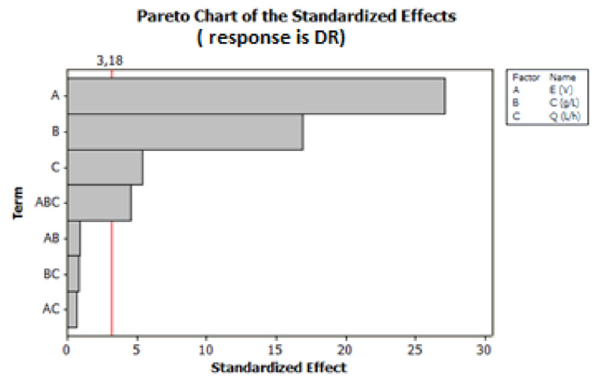
Fig. 2 Pareto chart for standardized effects for DR